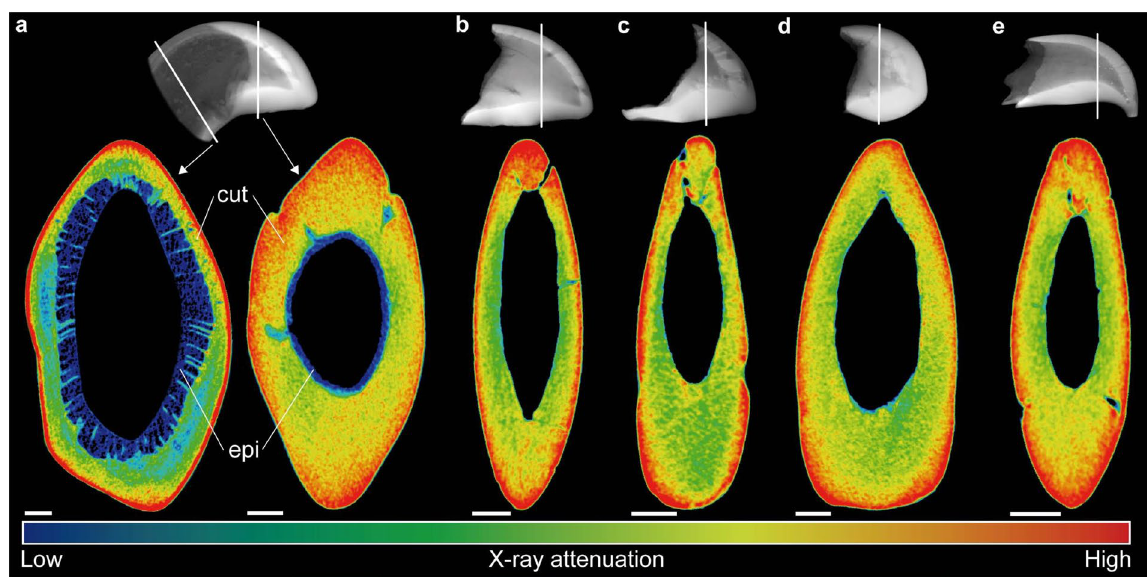
Figure 8. X-ray attenuation in an extant alpheid snapping claw and corresponding fossil samples. The upper line shows µ CT-based X-ray images that indicate the position of the false colour-coded virtual sections depicted below. ( a ) Extant specimen: Alpheus bisincisus (NHMW-CR-25767). ( b – e ) Fossil specimens: ( b ) UMJGP 211460, ( c ) NHMW 2016/0154/0010, ( d ) NHMW 2016/0154/0009, and ( e ) UMJGP 211461. Note that in ( a ) the musculature inside the claw was virtually removed to allow for better comparison. Scale bars equal 100 µ m. epi = epidermis, cut =